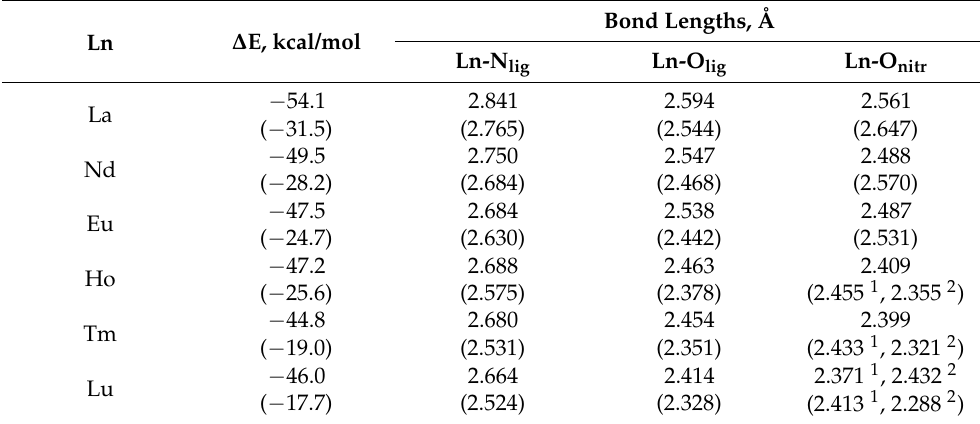
Table 1. Binding energies of the third nitrate anion to the [ L2 Ln(NO 3 ) 2 ] + cation ∆ E (kcal/mol) and the average bond lengths (Å) in the coordination site of the [ L2 Ln(NO 3 ) 3 ] complexes, calculated in the gas phase approximation and in a polar solvent (in parentheses).